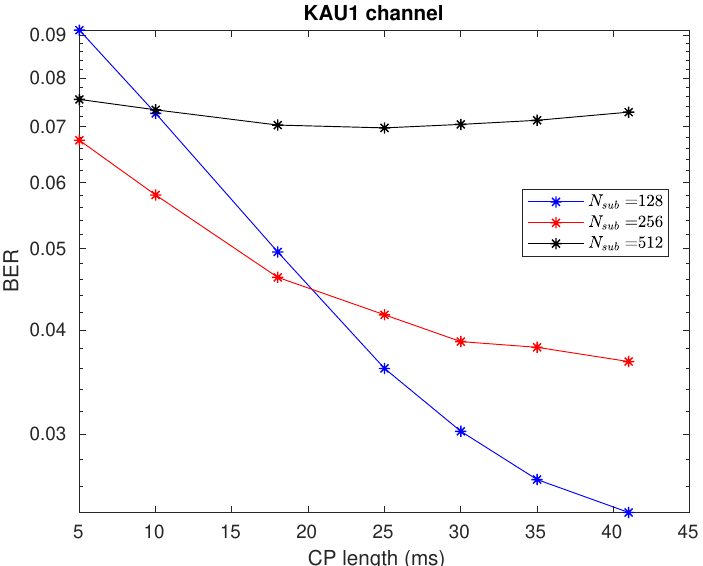
Figure 13. Results for KAU1 channel considering the genie − aided approach.